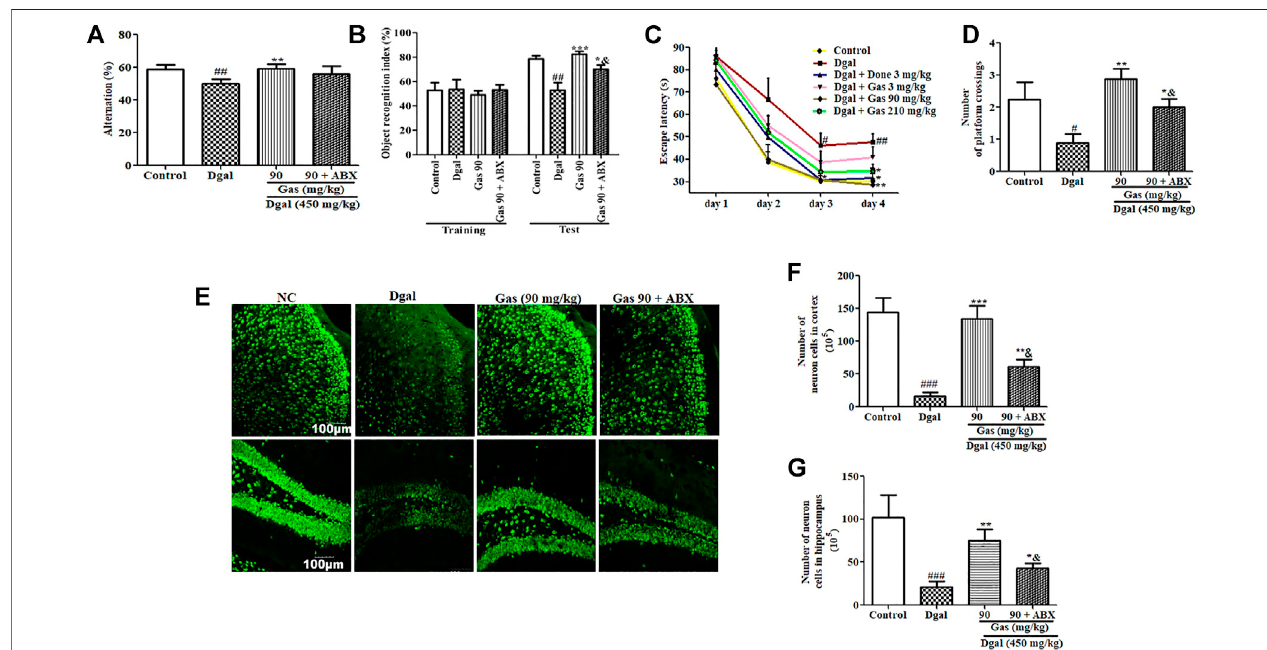
FIGURE 8 | Antibiotic cocktail partially diminishes the neuroprotective effect of Gas via the interference of gut microbiota. (A) Changes of alternation in the Y-maze test. (B) Object recognition index in the NOR test. (C) Escape latency in the training phase in the MWM test. (D) Number of platform crossings in the test phase in the MWMexperiment. (E) FluorescentimageofthecerebralcortexandhippocampusneuronsofADmiceaftertreatmentwithGas. (F,G) Digitalizedresultsofhippocampus andcerebralcortexneurons.Thebrainsofthreemiceineachgroupwerecut,andsixsectionsofthecerebralcortexandhippocampusofeachmousewereusedto calculate the neuron. The data are presented as means ± SEM. The data were presented as means ± SEM. #, ##, and ### indicate signi fi cant differences at p < 0.05, p < 0.01, and p < 0.001compared withthoseofthenormalcontrol,respectively; *,**,and*** indicatesigni fi cantdifferenceat p < 0.05, p < 0.01, and p < 0.001compared with those in the Dgal group, respectively. & represents signi fi cant difference at p < 0.05 compared with that of the Gas